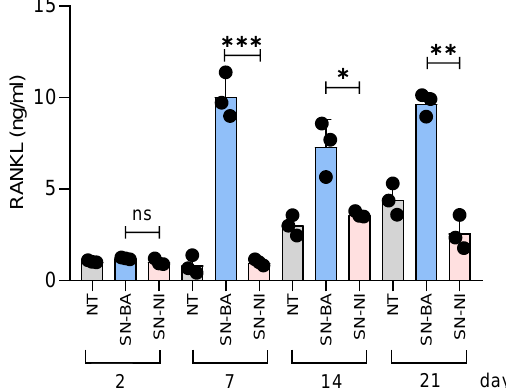
Figure 5. Culture supernatants from B. abortus -infected adipocytes induce RANKL expression by osteoblasts. RANKL production by osteoblasts stimulated with supernatants from B. abortus -infected adipocytes (SN-BA) or from adipocytes that were not infected (SN-NI) was determined in cell lysates by ELISA. NT: non-treated. * p < 0.001, ** p < 0.001, and *** p < 0.001 vs. cells treated with culture supernatants from non-infected cells (SN-NI). ns: non-significant.